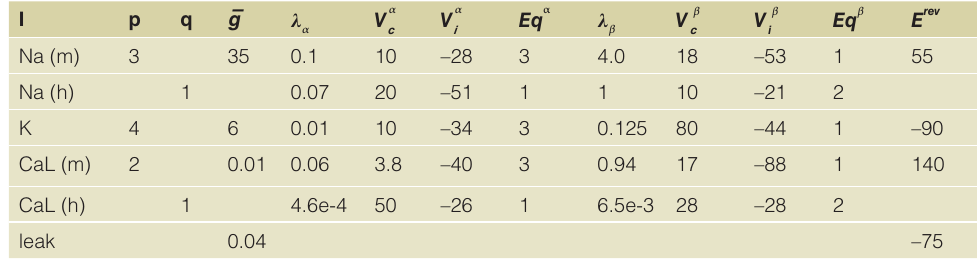
Table 2. Parameter values for potassium channels I Kir , I Af , I As and a slow sodium channel I Nas cf. 27,28 , where (a) τ